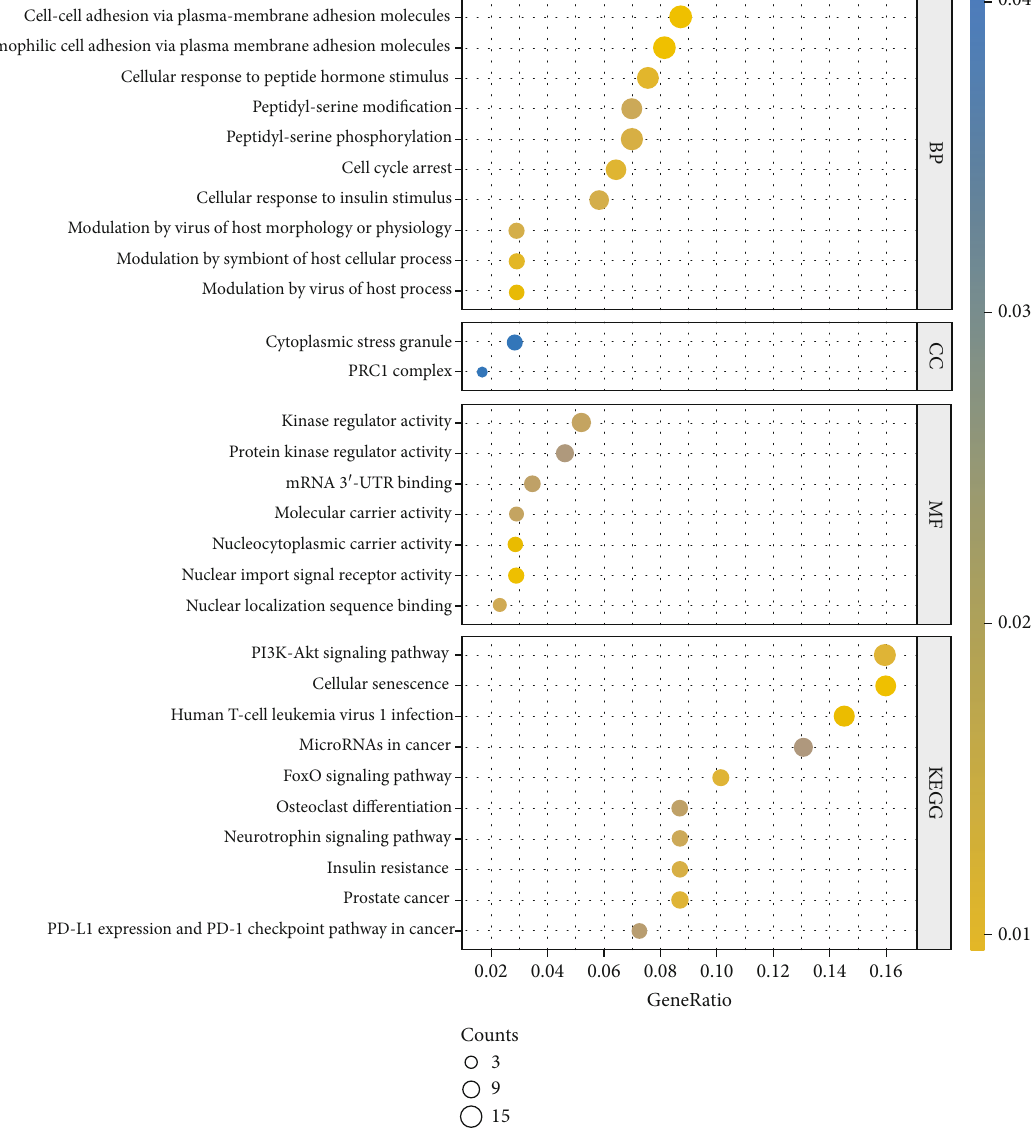
Figure 7: Gene Ontology (GO) analysis of the target genes of